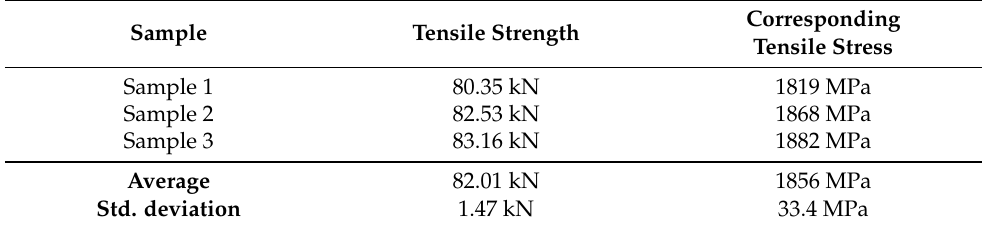
Table 7. Tensile strength with wedge